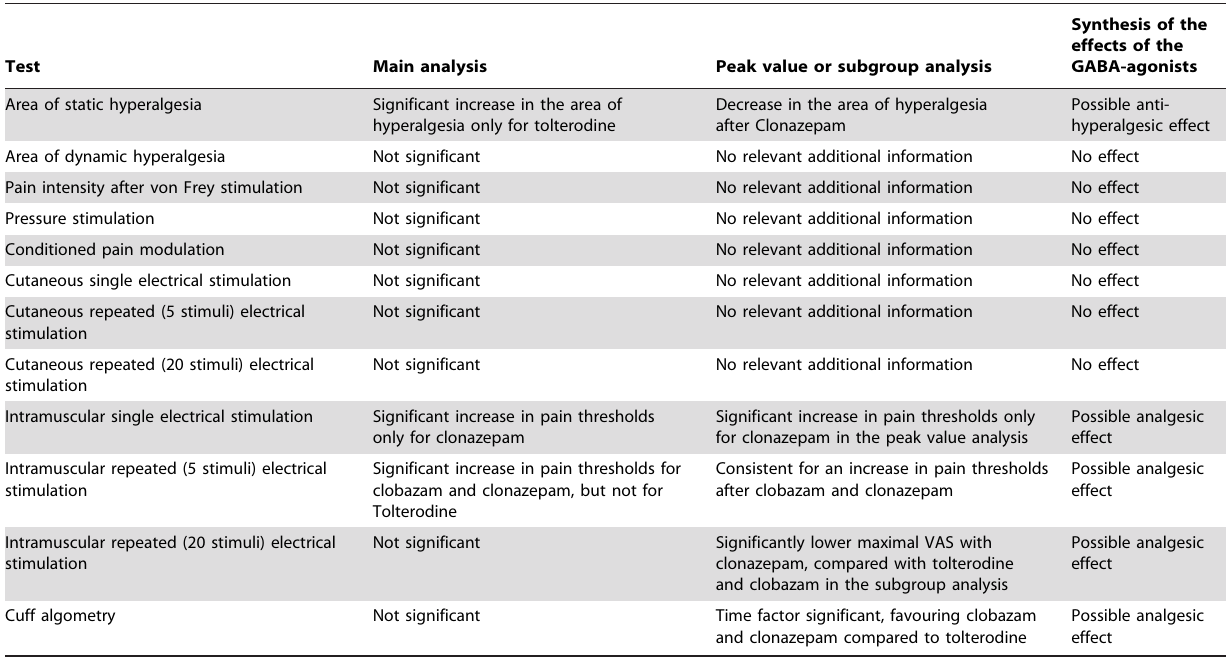
Table 4. Overview of the